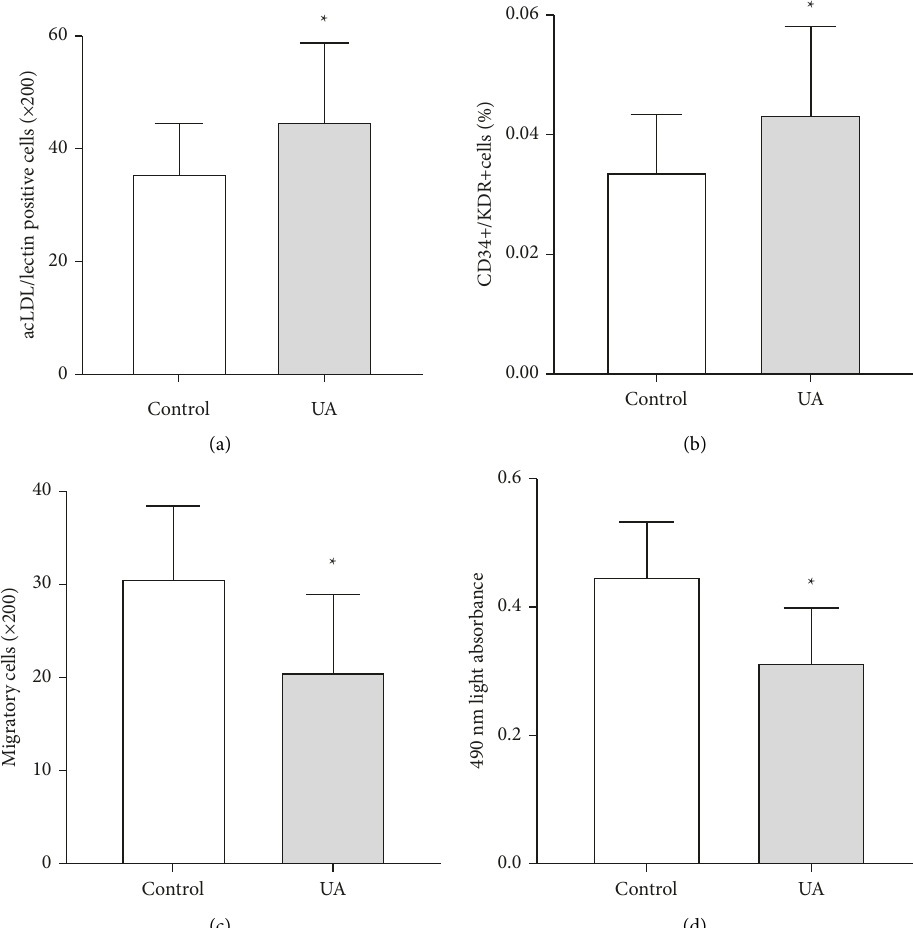
Figure 1: The number and function of circulating EPCs between the two groups. The number of circulating EPCs was detected by determining the number of CD34+/KDR+ cells per 100 peripheral blood mononuclear cells and then by examining the numbers of DiI- acLDL/lectin double-positive cells (a), (b) The results of migration and proliferation assays (c), (d) Statistical significance was evaluated using Student’s t -test or analysis of variance. ∗ P < 0 .